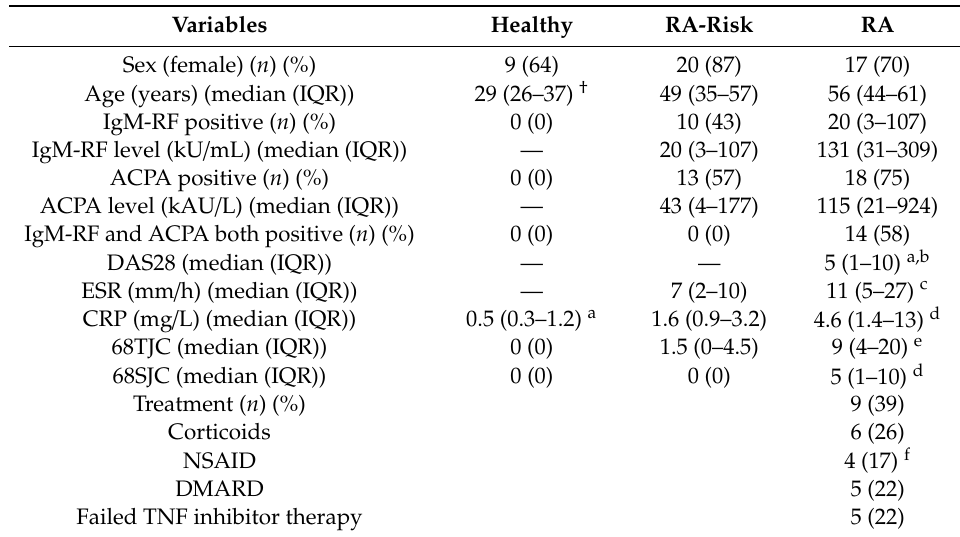
Table 1. Demographic data of study